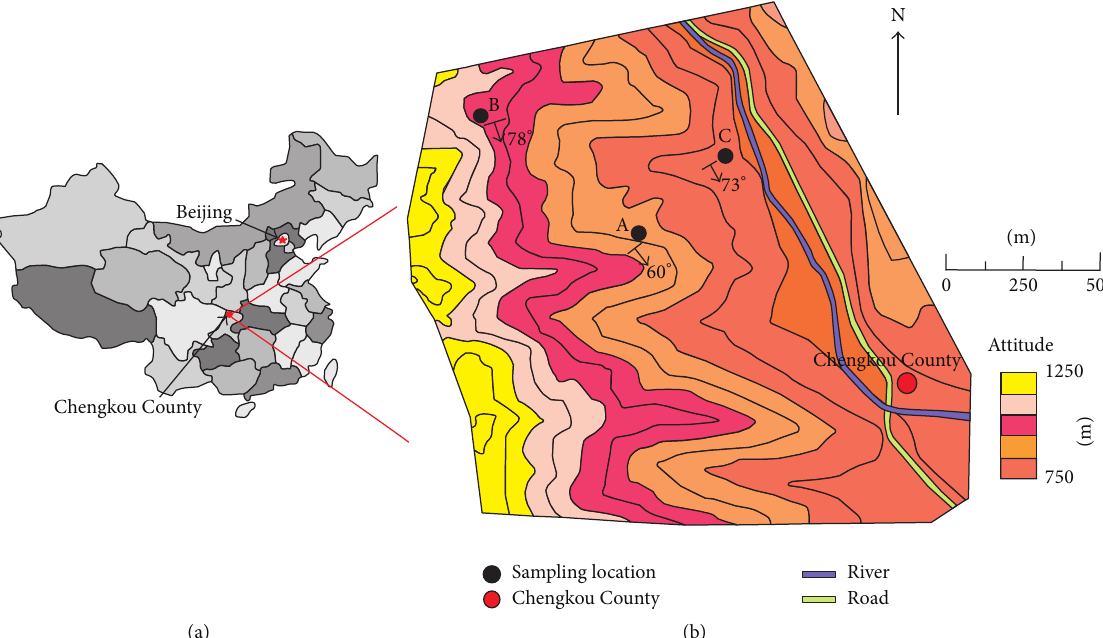
Figure 1: Study site on Shuijingtuo Formation black shale in Chengkou county, Northeast Chongqing Province. The samples were collected from nearby mountaintop (B), midridge (A), and valley floor (C). Background color indicates